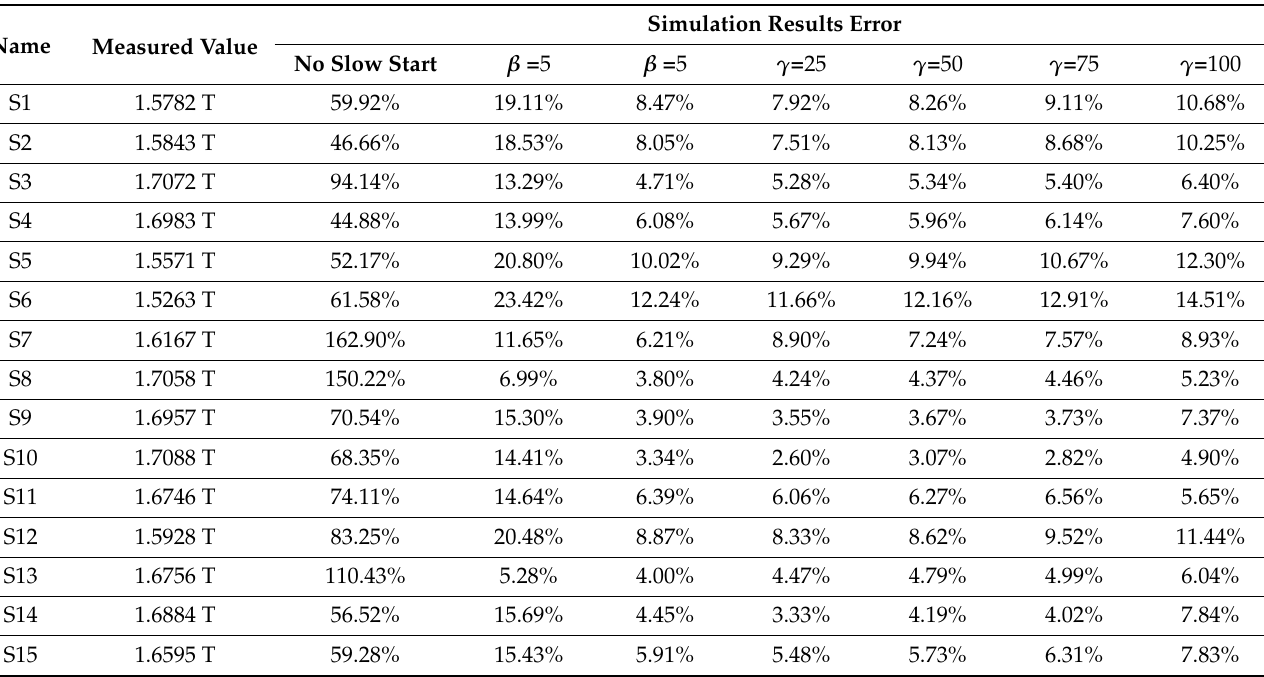
Table 6. Experimental results of magnetic flux density under different test coils.